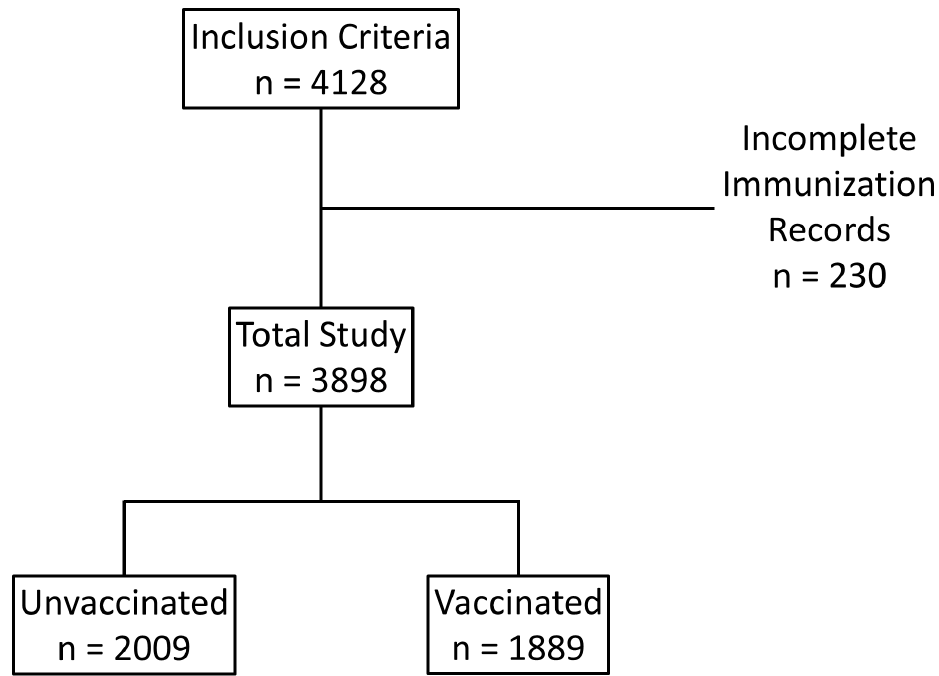
Figure 1. Patient Flow Diagram. Overall, 4128 patients met the inclusion criteria. From this, 230 patients were excluded due to incomplete immunization data. From 3898 patients included in the analysis, 1889 were vaccinated and 2009 were unvaccinated.